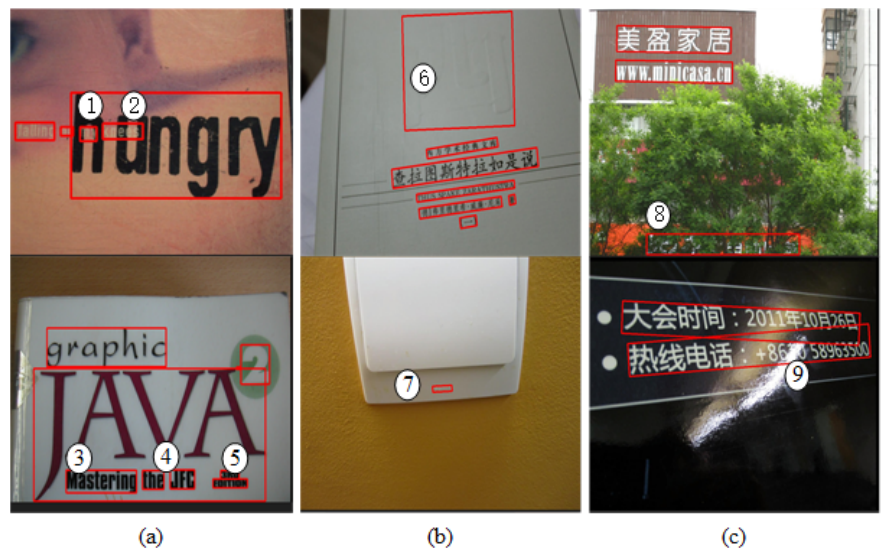
Figure 11. Somefaileddetectionexamplesoftheproposedmethod: ( a )overlappingtext; ( b )low-resolution text; ( c ) partially occluded text. The red lines mark text boxes, and the text markers (cid:172) – (cid:180) represent the text that is un-detected.